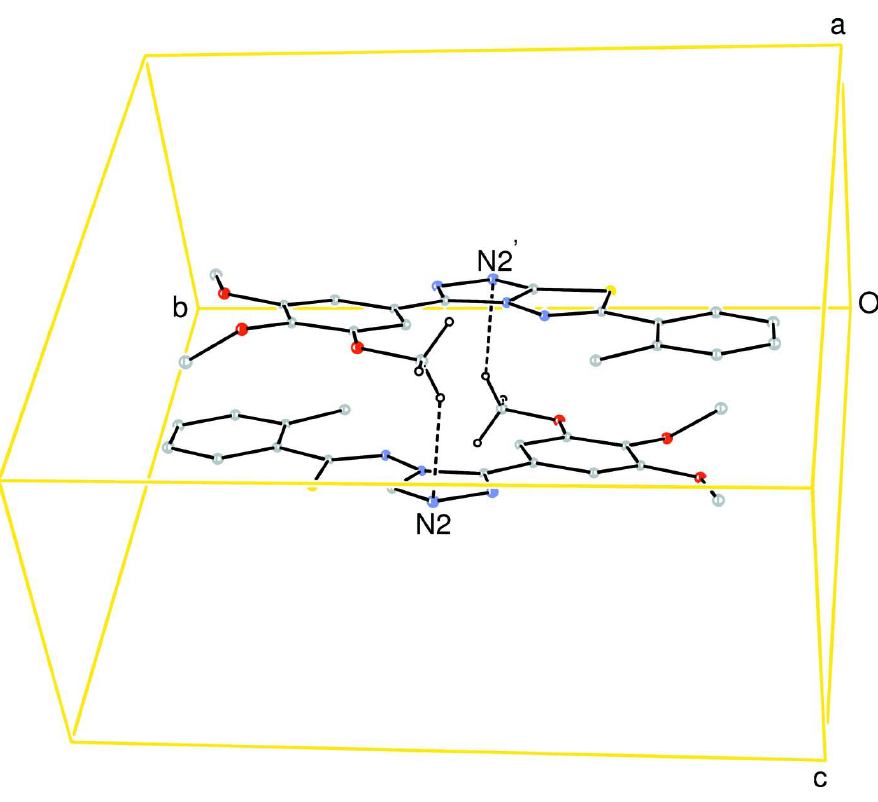
A partial packing diagram of the title compound [symmetry code: (′) -x, -y, -z]. Hydrogen bonds are shown as dashed